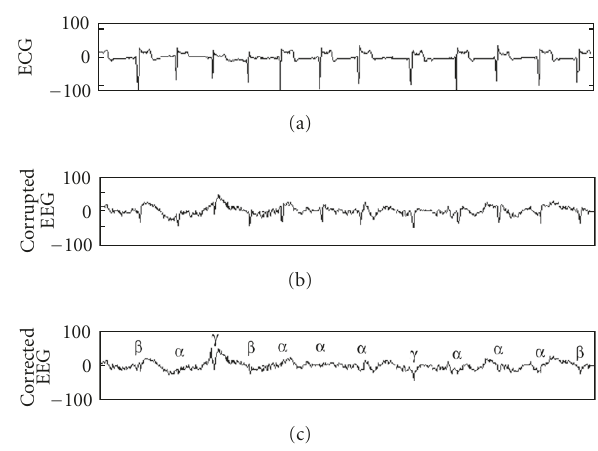
Figure 14: Examples of various peaks on the corrected signal- α : corrected peaks, β : half-corrected peaks, γ : uncorrected or very badly-corrected peaks.